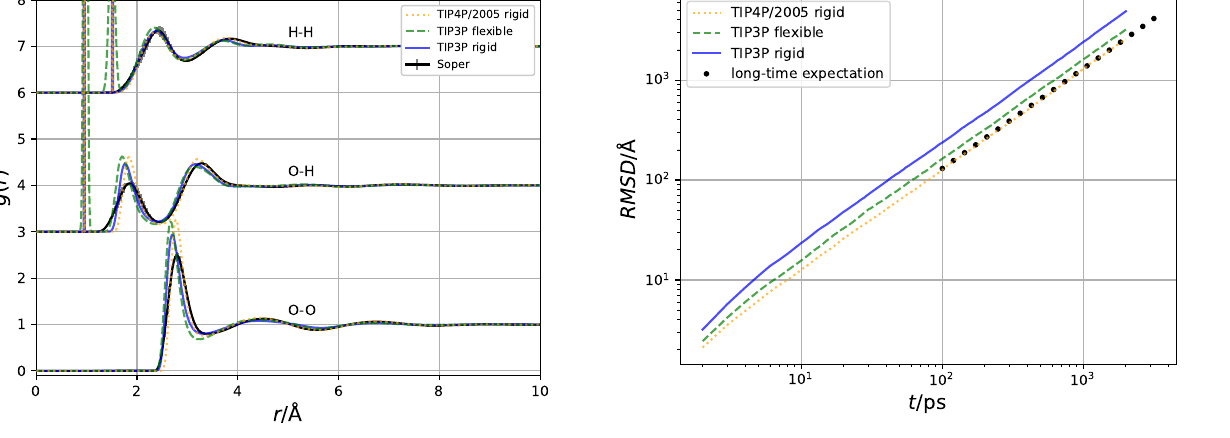
Figure 3. RDFs g ( r ) of TIP3P rigid, TIP3P flexible, and TIP4P / 2005 rigid for O–O, O–H, and H–H correlations. O–H was shifted by an o ff set of 3 on the y -axis and H–H was shifted by an o ff set of 6 on the y -axis. The computed RDFs are com- pared to literature values from [36]